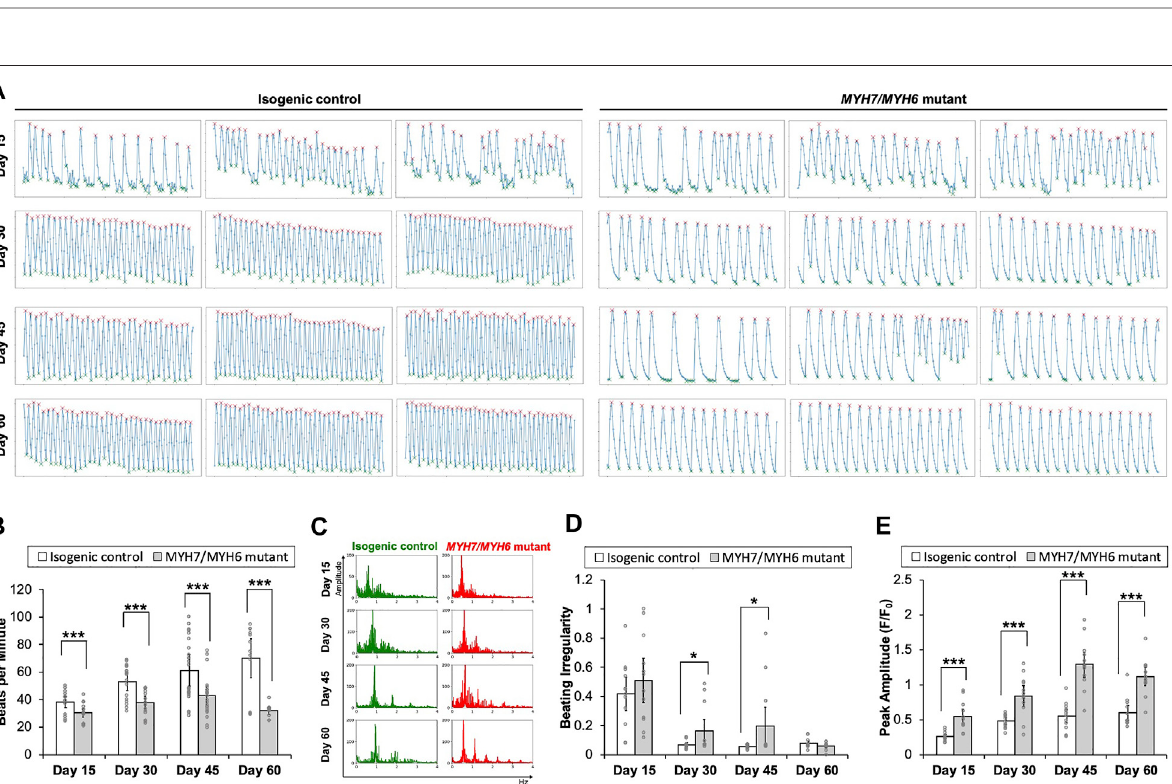
FIGURE 2 | immunostained and DAPI-stained hiPSC-CMs to visualize nucleation in the differentiated cardiomyocytes using the isogenic control and MYH7/MYH6 mutantlines.Redarrowsindicatemulti-nucleatedcells.LeftimagesshowDay30re-platedhiPSC-CMsandRightimagesshowDay60re-platedhiPSC-CMs.(ScaleBar = 100 μ m). (E) Bar graph shows that quanti fi cation of the percentage of hiPSC-CMs with more than one nucleus. Note signi fi cant increase in the multinucleated cells in themutantconditionsrelativetocontrolcells.Datarepresentsmean±SEM.(** p < 0.01;*** p < 0.005;Student t test; n =9immunostainedimagesforDay15conditions, n = 18 immunostained images for Day 30, Day 45, and Day 60, respectively). (F) High magni fi cation fl uorescence images of cTnT and DAPI-stained hiPSC-CMs to analyze the sarcomeric organization in the control and R723C mutant cardiomyocytes. (Scale Bar = 50 μ m). (G) Bar graph shows percentage ofhiPSC-CMswith highly organized sarcomere. Data represents mean ± SEM. (*** p < 0.005; N.S. : not signi fi cant; Student t test; n = 9 immunostained images for Day 15 conditions, n = 18 immunostained images for Day 30, Day 45, and Day 60, respectively).